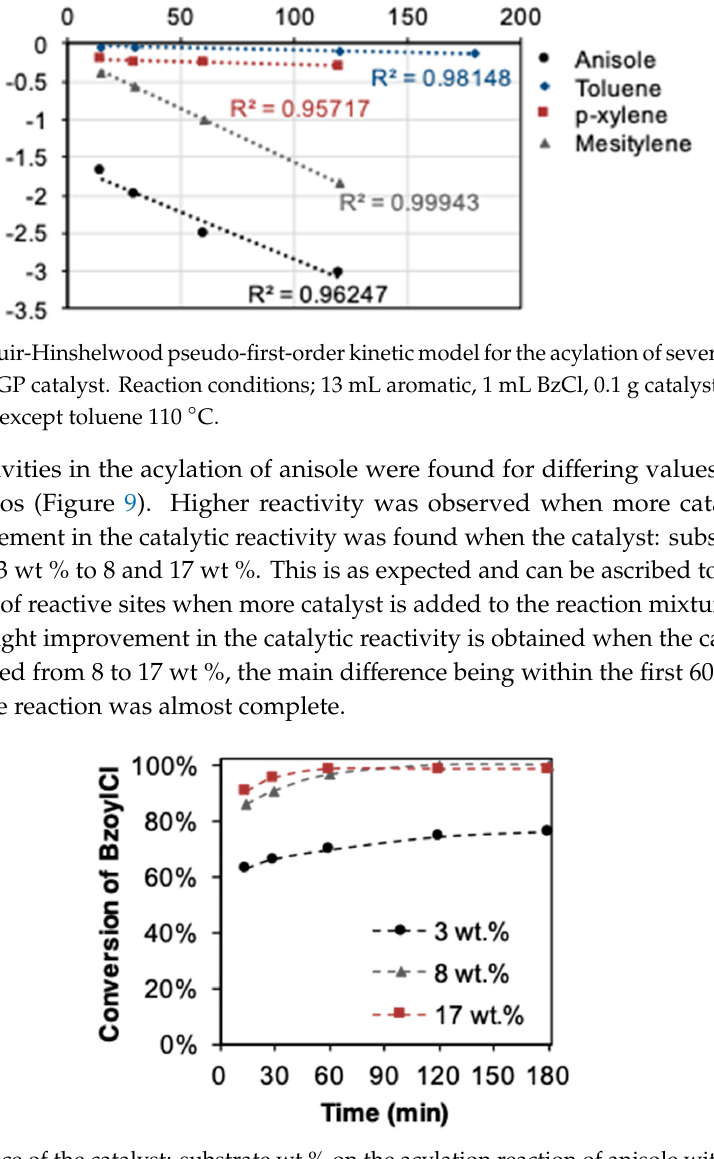
Figure 9. Influence of the catalyst: substrate wt % on the acylation reaction of anisole with BzCl over Huntly-GP catalyst. Reaction conditions; anisole: BzCl wt % 13; T = 130 °C.